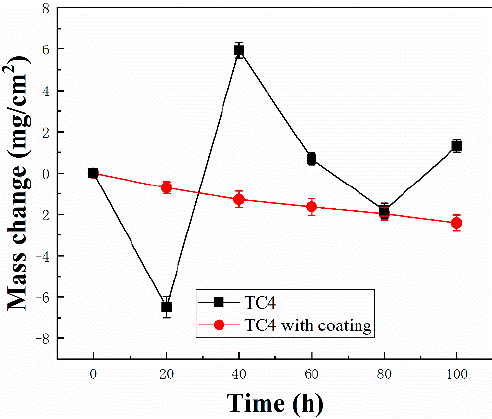
Figure 2. Corrosion kinetic curves of TC4 with and without coating after corrosion in marine environment for 100 h at 650 °C.